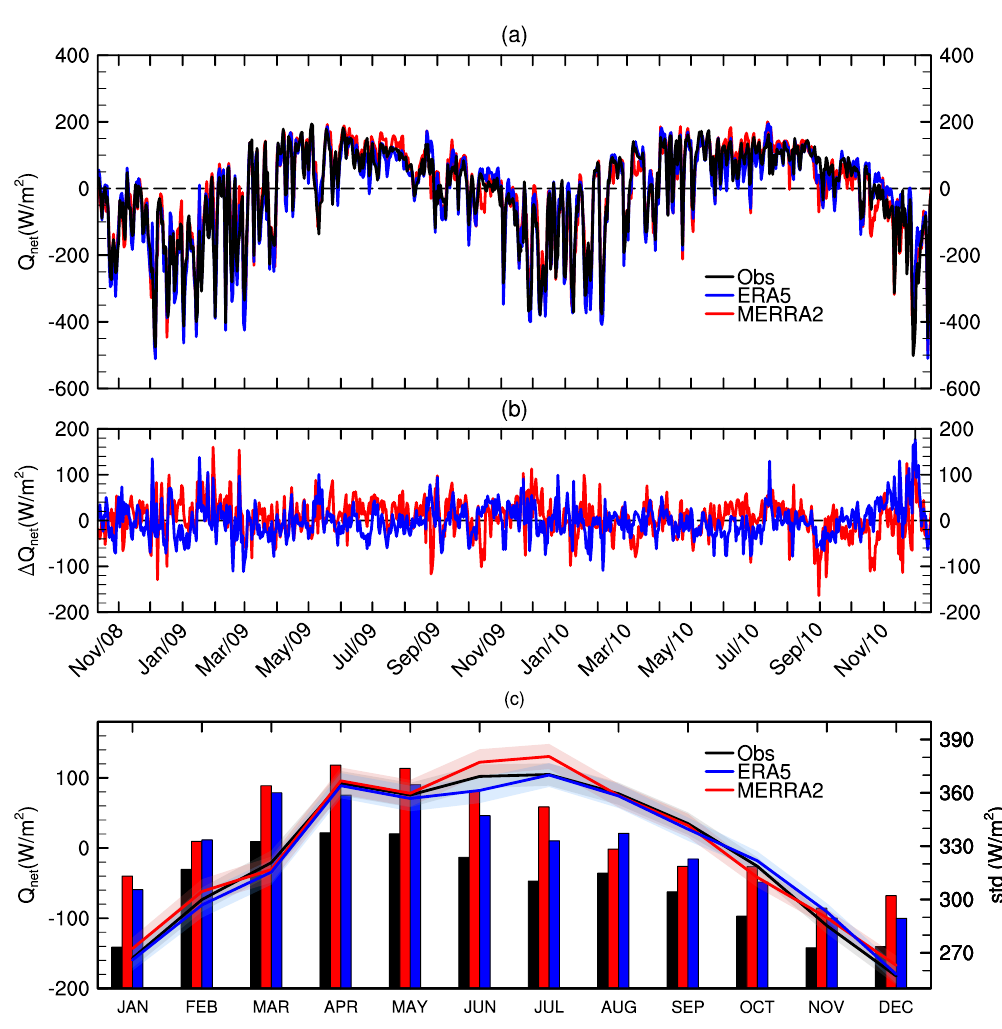
Figure 10. Time-averaged net heat fluxes obtained using reanalysis products and observational data at the WHOI/KAUST buoy site (22.17 ◦ N; 38.50 ◦ E) between 2008 and 2010. Blue lines: ECWMF-ERA5 reanalysis data; red lines: NASA-MERRA2 reanalysis data; black lines: observations. ( a ) Daily net surface heat fluxes. The dashed line marks the Q net = 0. ( b ) Daily average differences between reanalysis products and observations. ( c ) Monthly-average (curves; using left vertical axis) and respective standard deviations (bars; using right vertical axis). Shadings are the respective 95% bootstrap confidence interval over the mean (bias-corrected and accelerated percentile method using 10,000 bootstrap samples). Negative values in all panels indicate sea heat